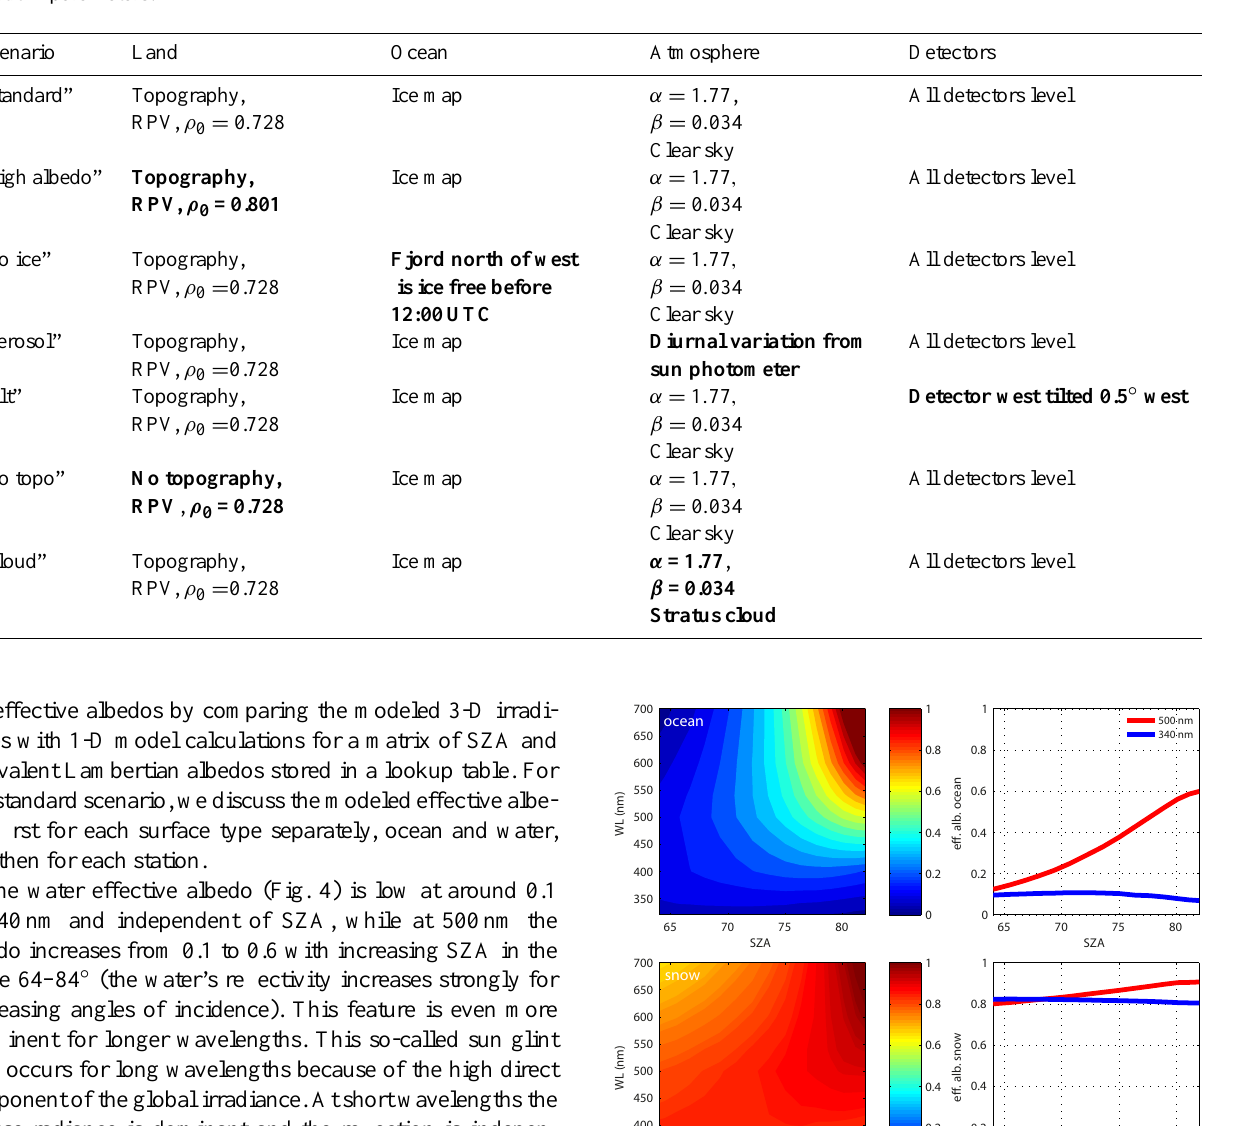
Table 1. Relevant input parameters for each modeled scenario with respect to land, ocean and atmosphere characteristics. Bold text indicates the respective parameter that has been modified for the scenario. ρ 0 is the albedo parameter in the snow RPV model, α and β are the aerosol Ångstrom parameters.